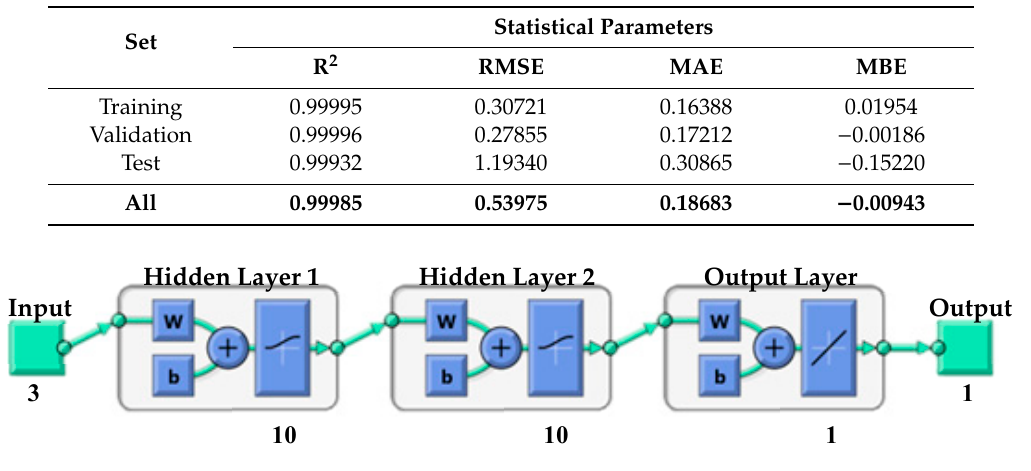
Figure 6. Regression plots of (a) training data, (b) validation data, (c) test data, and (d) complete data set of the selected ANN model. Then, the performance of the selected model was evaluated by different statistical parameters such as R 2 , MAE, RMSE, and MBE. Error! Reference source not found. lists the values of these parameters. The high value of R 2 along with very low values of MAE, RMSE, and MBE indicates a high-efficient performance of the selected model [14]. Table 9. Statistical parameters of the ANN11 model. Set